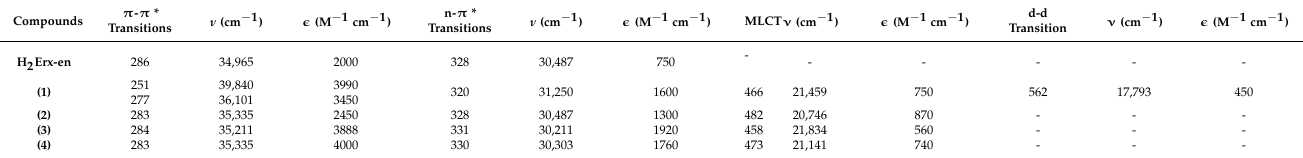
Table 3. UV-Vis. spectra for H 2 Erx-en and its metal complexes.